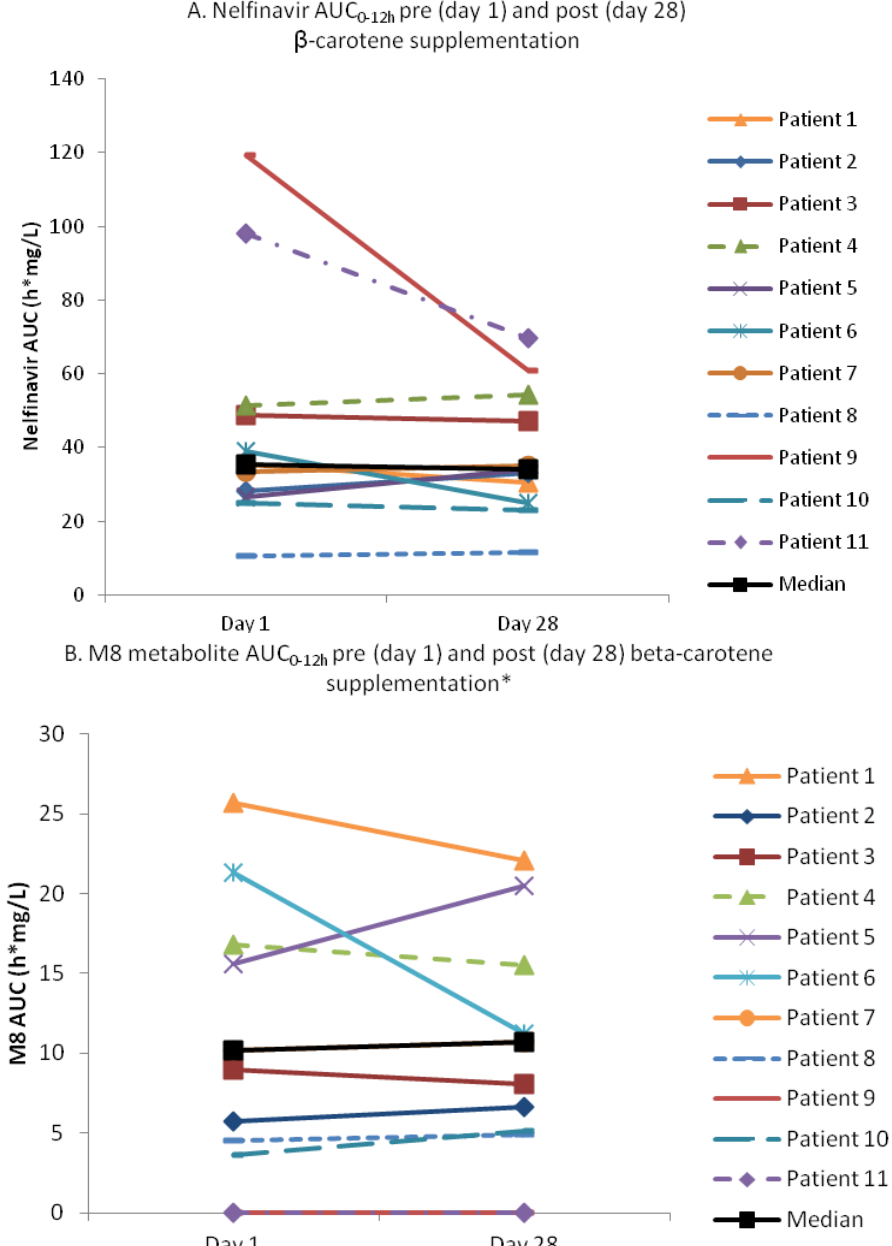
Figure 2. Individual steady-state area under the plasma concentration-time curve from 0 to 12 hours post-dose (AUC ) of nelfinavir and its M8 metabolite at baseline and after 0–12 h 28 days of β -carotene supplementation (25,000 IU twice daily)